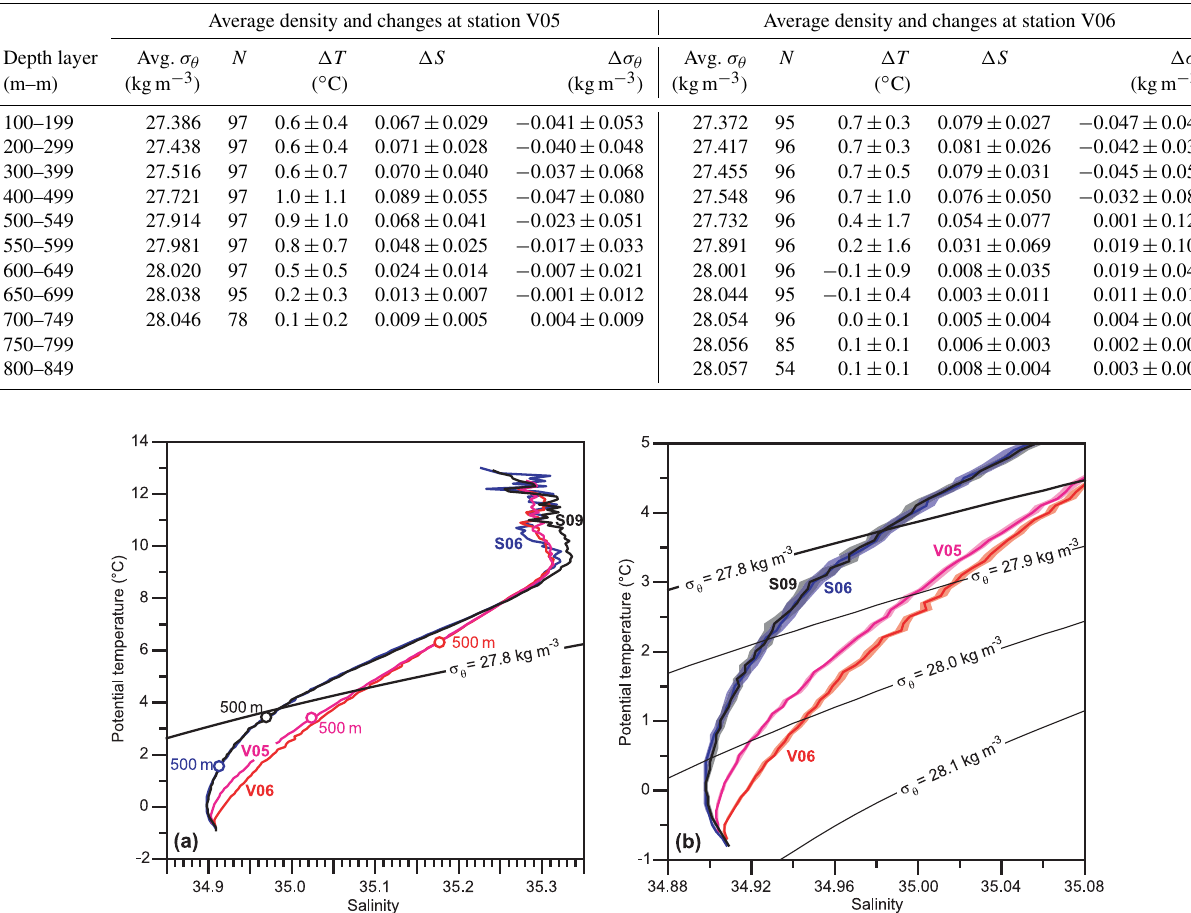
Table 1. Overall change from 1996 to 2015 according to linear trend analyses for various depth layers at stations V05 and V06. For each layer, the table shows average potential density (avg. σ θ ) , number of CTD occupations ( N ), and changes in temperature ( (cid:49)T ), salinity ( (cid:49)S ), and potential density ( (cid:49)σ θ ) .